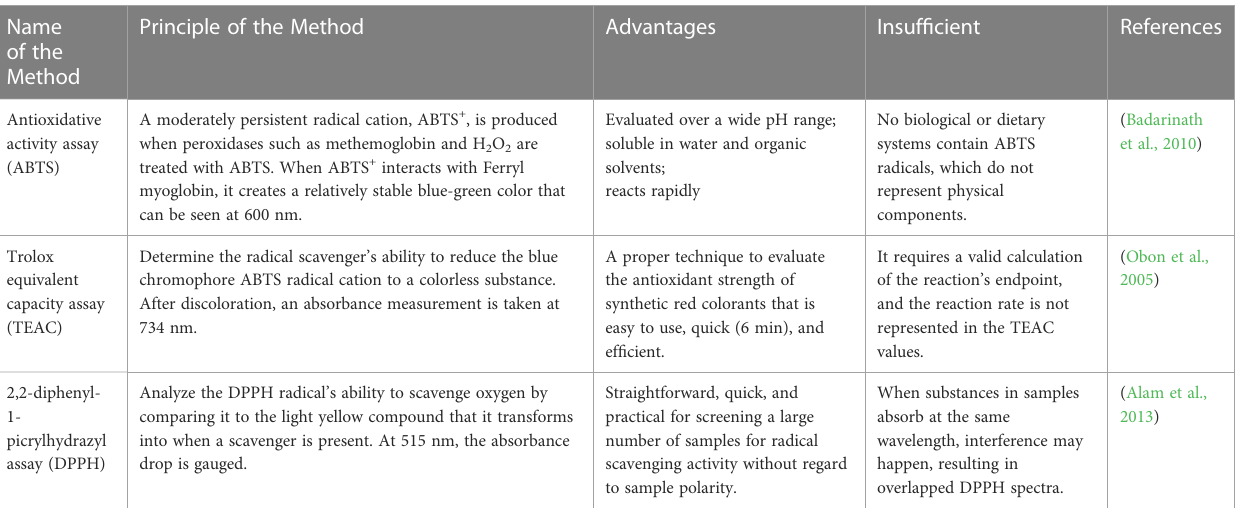
TABLE 5 Main methods for assessing antioxidant